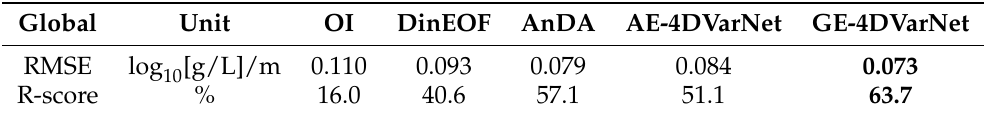
Figure 5. Reconstruction of SSSC gradient fields: ( a ) reconstruction obtained by OI, AnDA, DINEOF, AE-4DVarNet, and GE-4DVarNet on average for the whole 100-day validation period. ( b ) map of the mean reconstruction error for the 100-day validation period for OI, DinEOF, AnDA, AEP-4DVarNet, and GE-4DVarNet. Table 2. Mean RMSE and R-score for the norm of the SSSC gradients computed for all methods over the 100-day validation